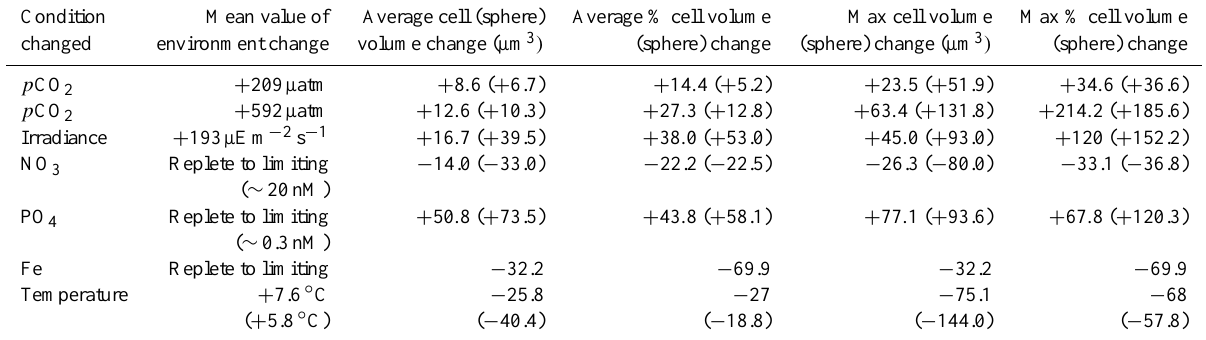
Figure 4. Effect of suboptimum growth conditions on allometric relationships for coccolithophores. (a) Rate of photosynthesis, (b) growth rate, and (c) rate of calcification. Suboptimum light and nutrient conditions result in cells having reduced metabolic rates compared to cells of equal size grown in optimal growth conditions (see Table 2 for definition of growth conditions). The error bars apply only to a limited number of experiments (see text) and correspond to those experiments where the sampling time is not reported. Table 3. Changes in cell and coccosphere (sphere) volume for given changes in environmental conditions in culture